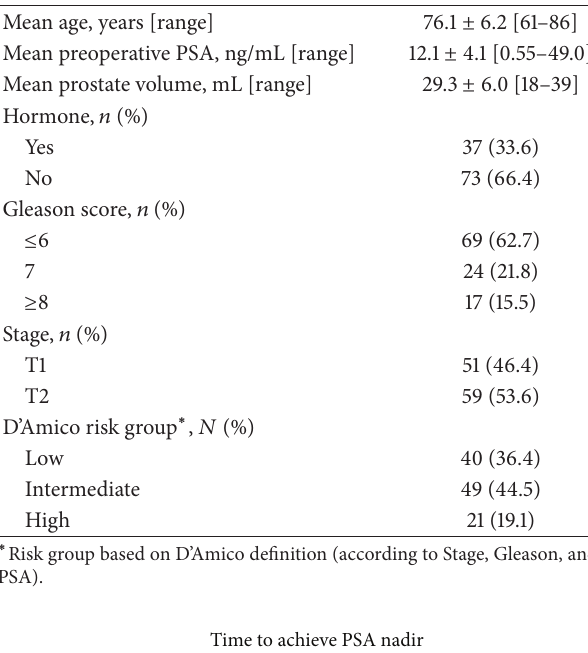
Table 1: Baseline patient characteristics after matching. Table 2: Baseline and tumour characteristics of 110 patients with localized prostate cancer who were treated by a single session of high intensity focused ultrasound.